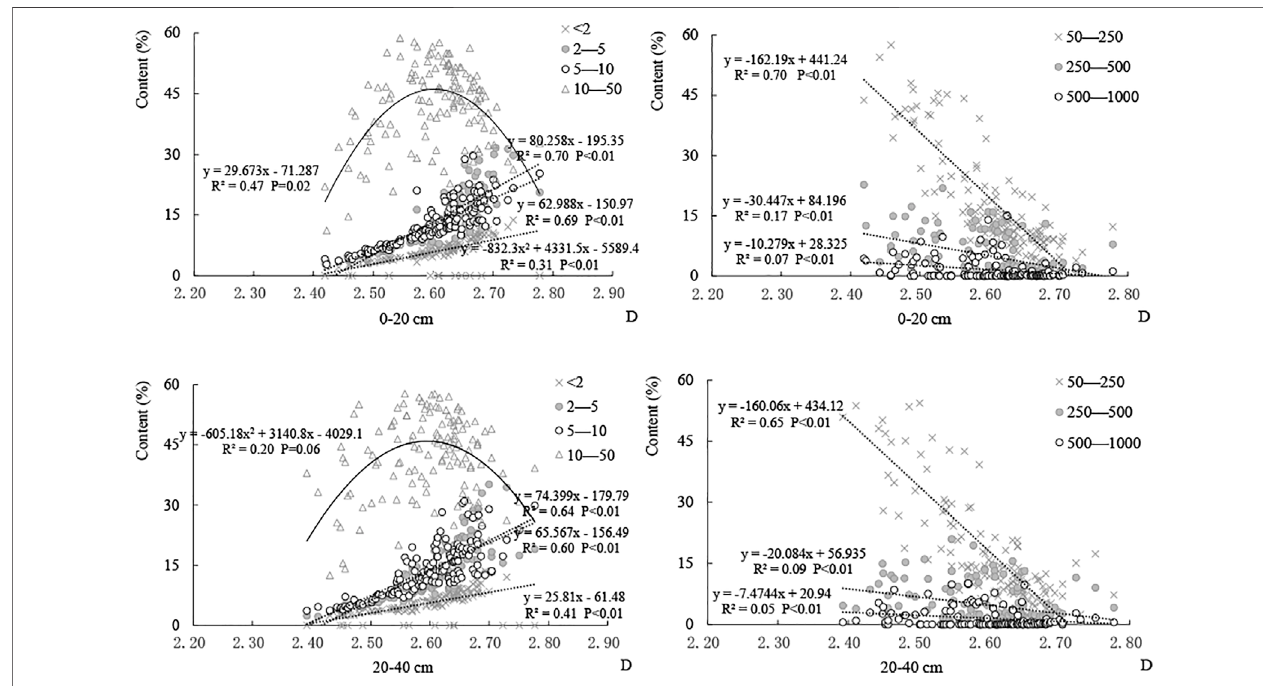
FIGURE 3 | Content relationship between D and the particle size in the farmland (NF) in the non fl ooded area.